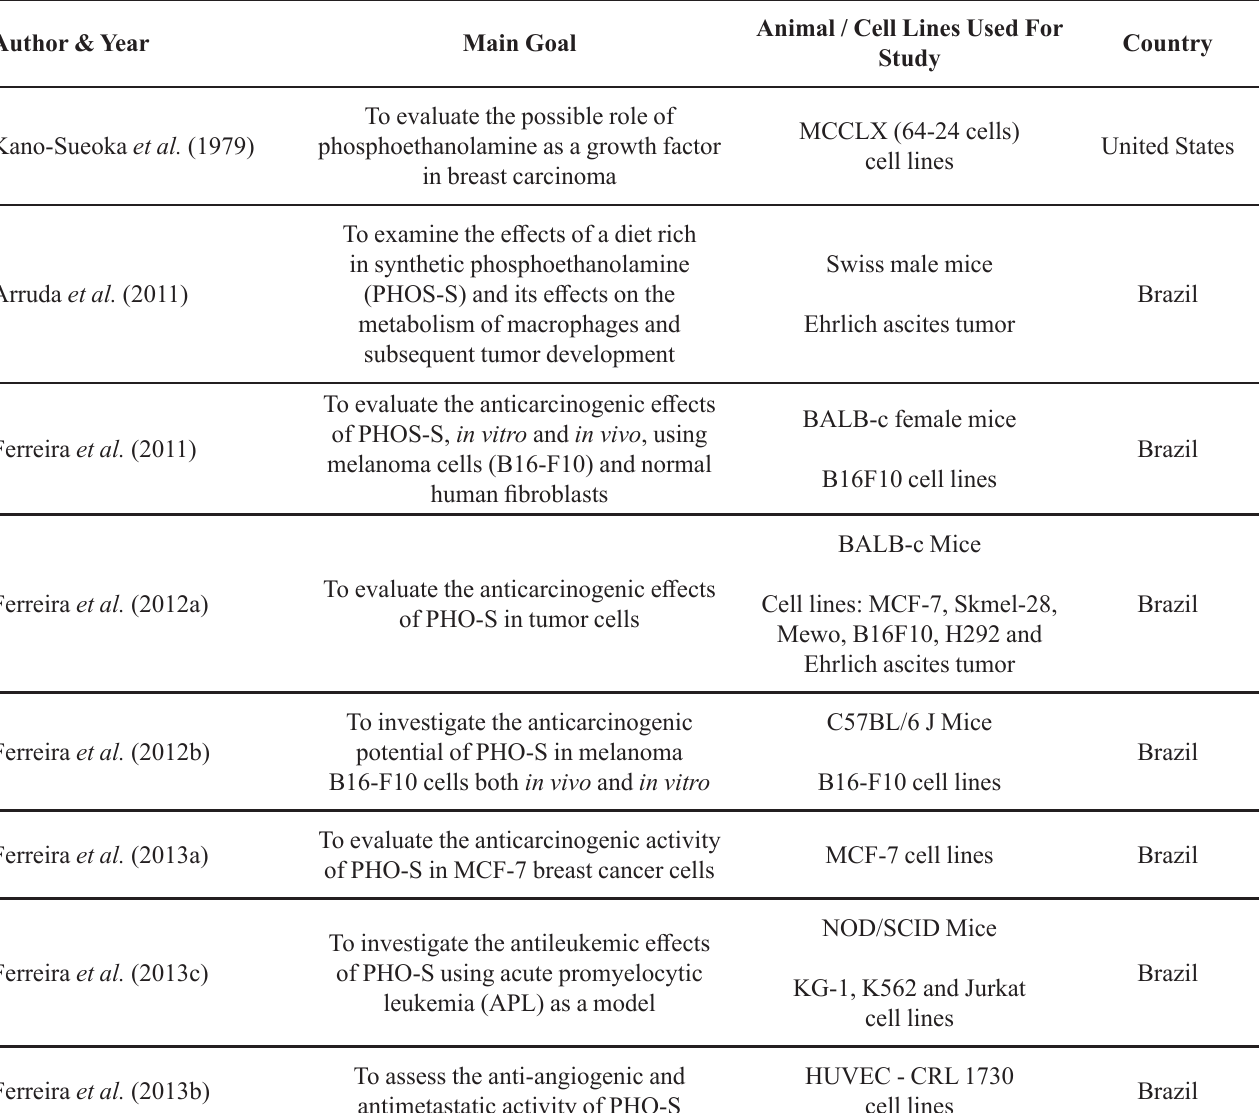
TABLE II - Description of the articles included in the systematic review of the synthetic phosphoethanolamine and its anticarcinogenic effects, according to the main